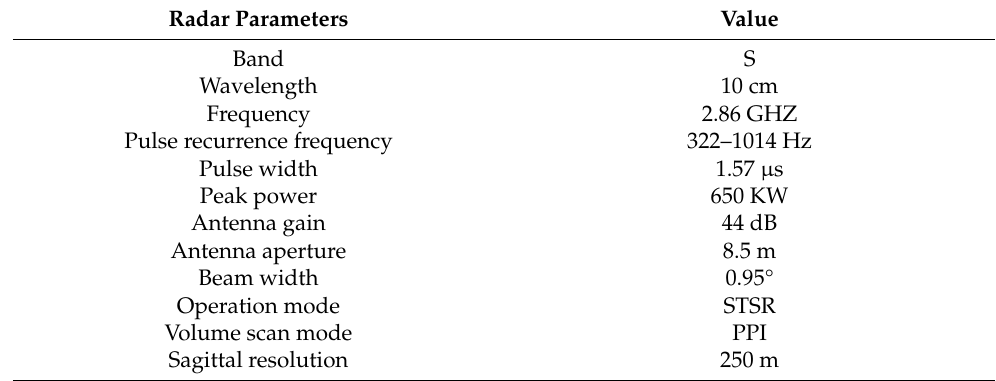
Table 2. Radar parameter